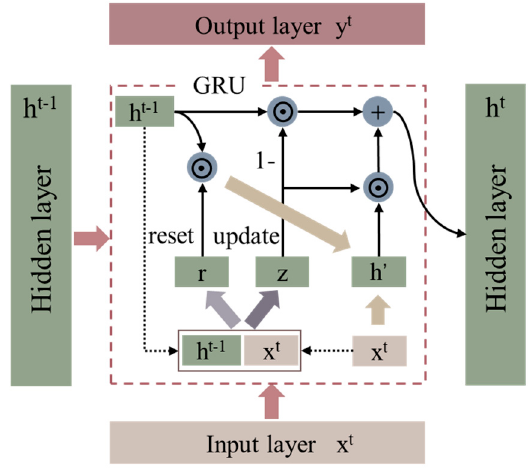
Figure 4. Schematic of GRU model.